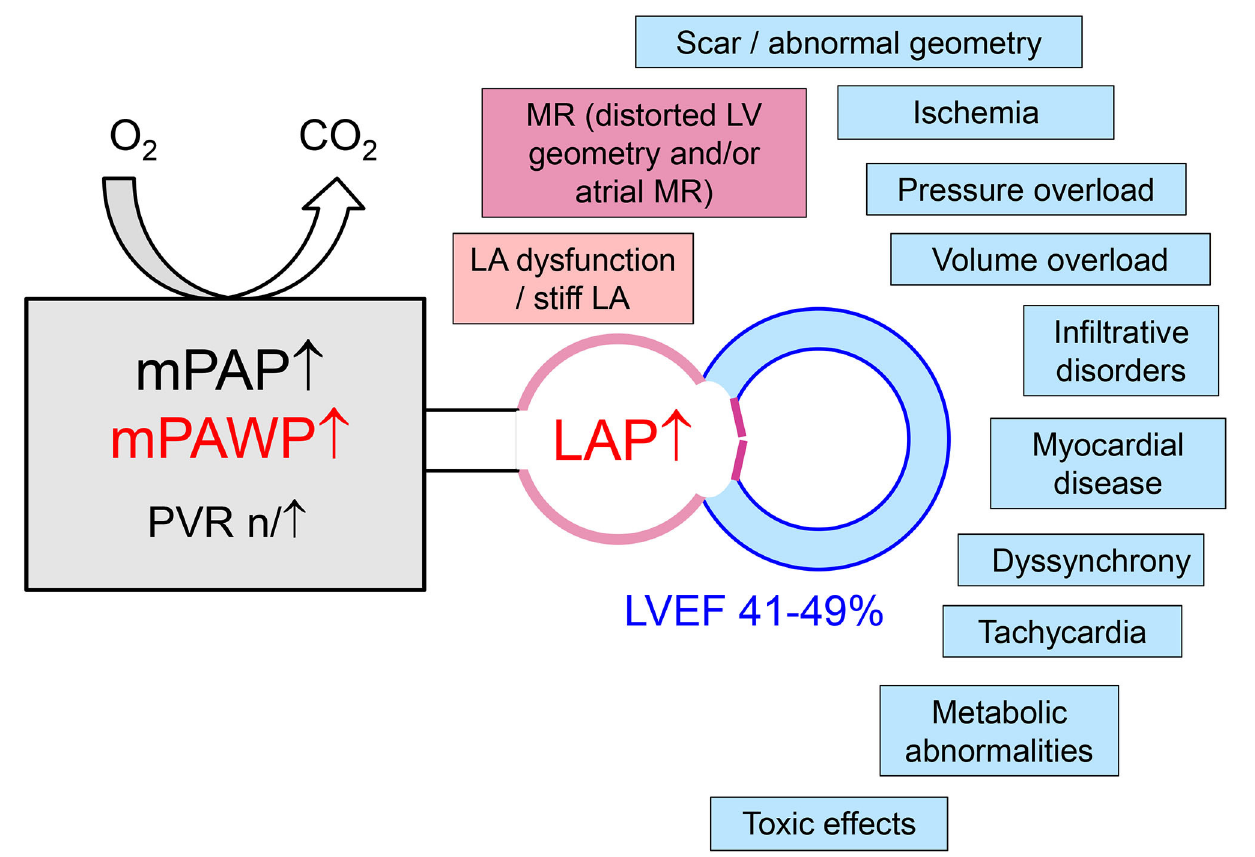
FIGURE 1 | Mechanisms of left atrial pressure (LAP) elevation in patients with pulmonary hypertension in the context of left heart disease with a left ventricular ejection (LVEF) in the mid-range of 41–49%. LA, left atrial/atrium; LV, left ventricular; mPAP, mean pulmonary artery pressure; mPAWP, mean pulmonary artery wedge pressure; MR, mitral regurgitation; PVR, pulmonary vascular